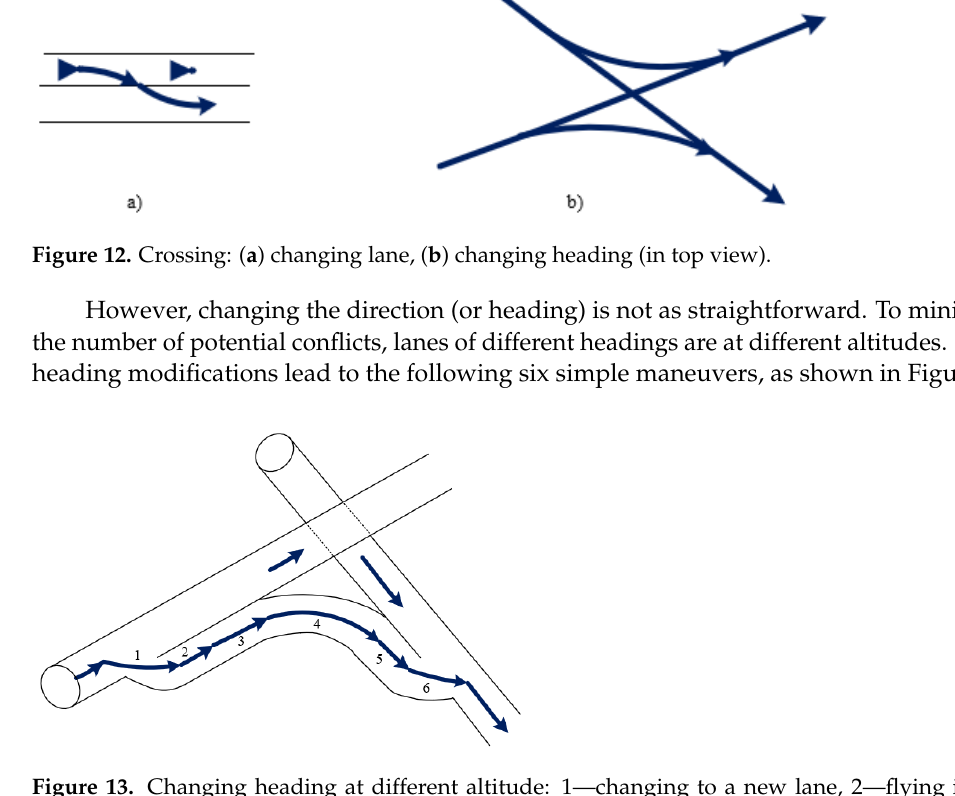
Figure 13. Changing heading at different altitude: 1 — changing to a new lane, 2 — flying in the new lane, 3 — increasing/decreasing the altitude, 4 — turning on the same altitude, 5 — flying at the new lane in the desired heading, 6 — merging in the lane at the same altitude and at the desired new heading.